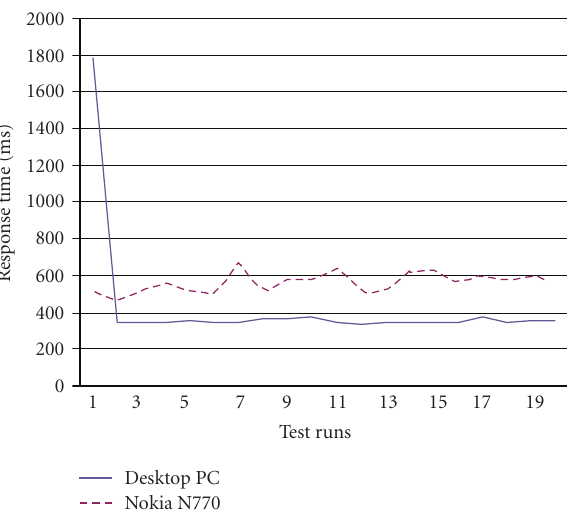
Figure 12: Response times to GetContextInfo action